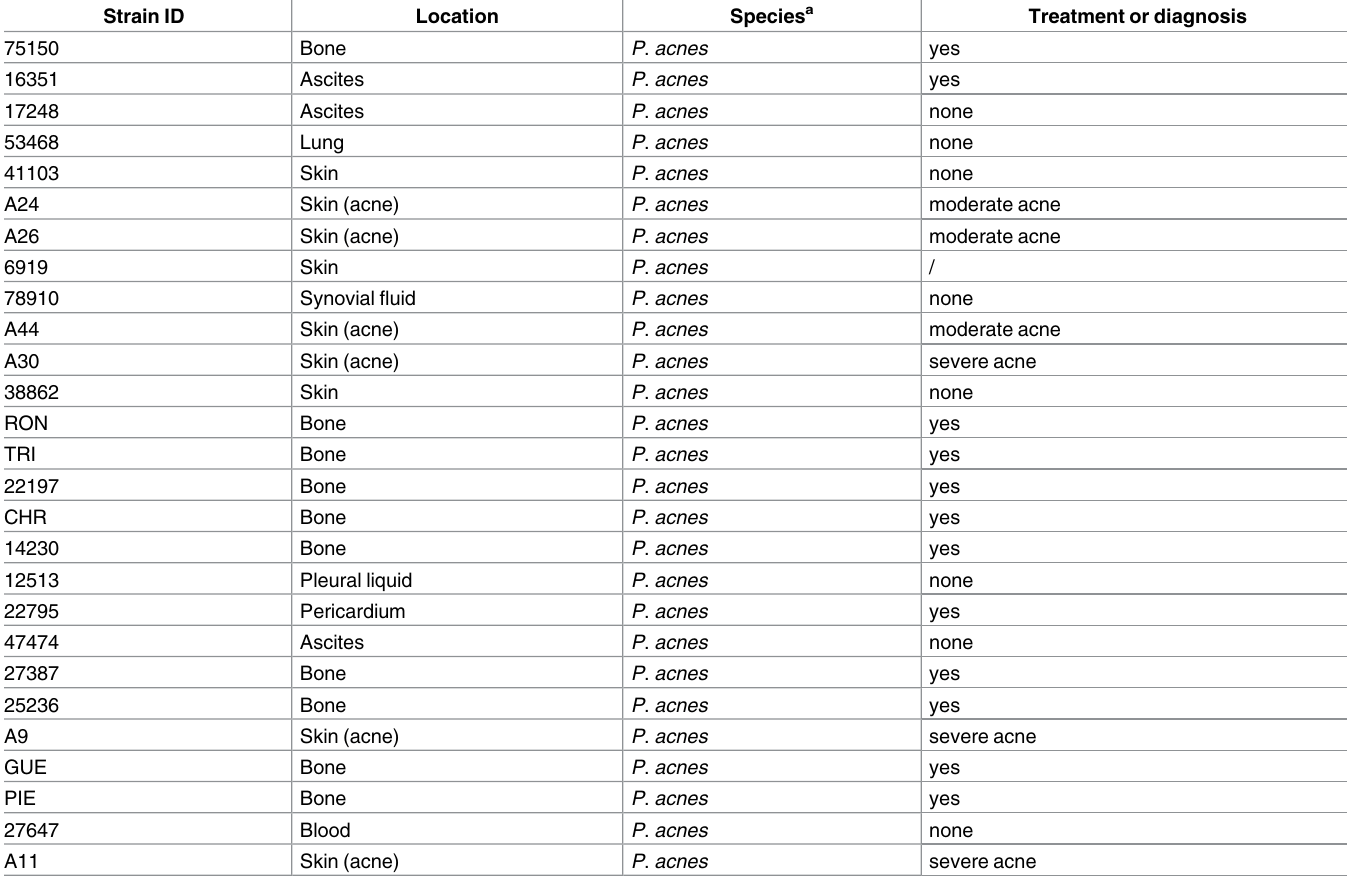
Table 3. Characteristics of P . acnes strains Strain